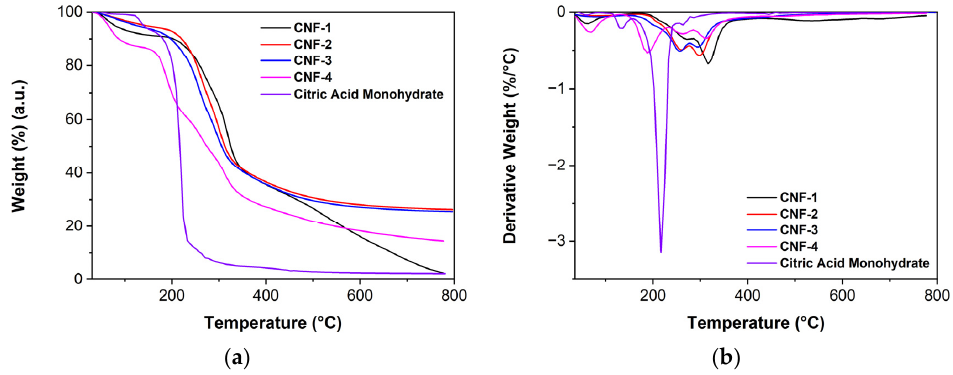
Figure 4. ( a ) TGA and ( b ) DTG graphs of CNF and raw materials. The DTG curves of the samples are shown in Figure 4b. For the cross-linked CNF membranes, the initial mass loss of around 100 °C results from the dehydration of the membrane. In CNF-4, the peak at approximately 190 °C, which corresponds roughly to the mass loss of water from citric acid monohydrate, may be attributed to the citric acid that is in excess and is not chemically bonded to the CNF membranes. The peaks at approximately 250 °C and 300 °C correspond to the degradation of the anhydroglucoronic and anhydroglucose units in CNF, respectively [58]. In addition, for CNF-4, the degradation peak at approximately 190 °C can be observed but is absent in the CNF samples with lower citric acid content. This peak shares a similar onset temperature (approximately 170 °C) with the second degradation step of